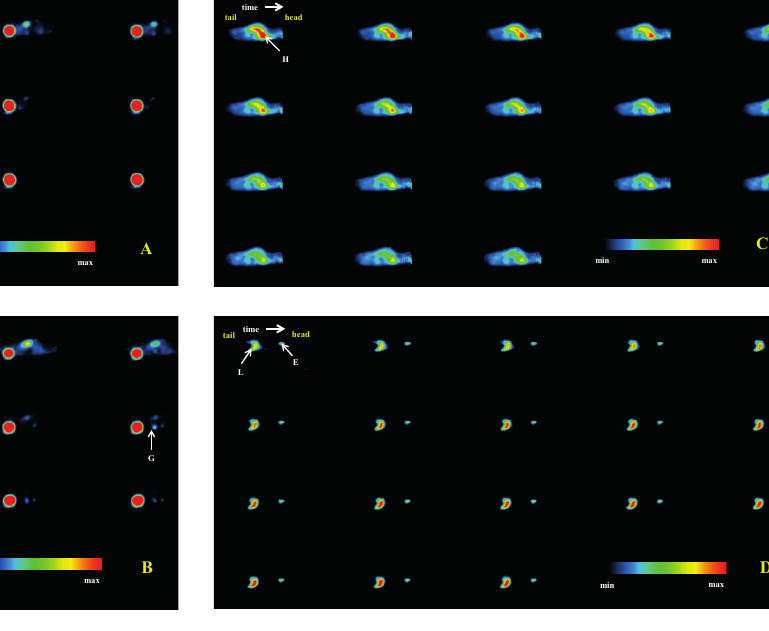
Fig. 2. Dynamic μPET imaging of 68 Ga-TAFC (A), 68 Ga-FOXE (B), 68 Ga-acetate/colloid (C), 68 Ga-colloid (D) and 68 Ga-citrate (E) up to 90 min p.i. (sagittal slices; injected dose: 5-10MBq; anaesthesia: 2% isoflurane; scan duration: 5-minute PET scan per frame (18 frames); B – bladder, E – eye, G – gastrointectinal tract, H – heart, K – kidney, L - liver).